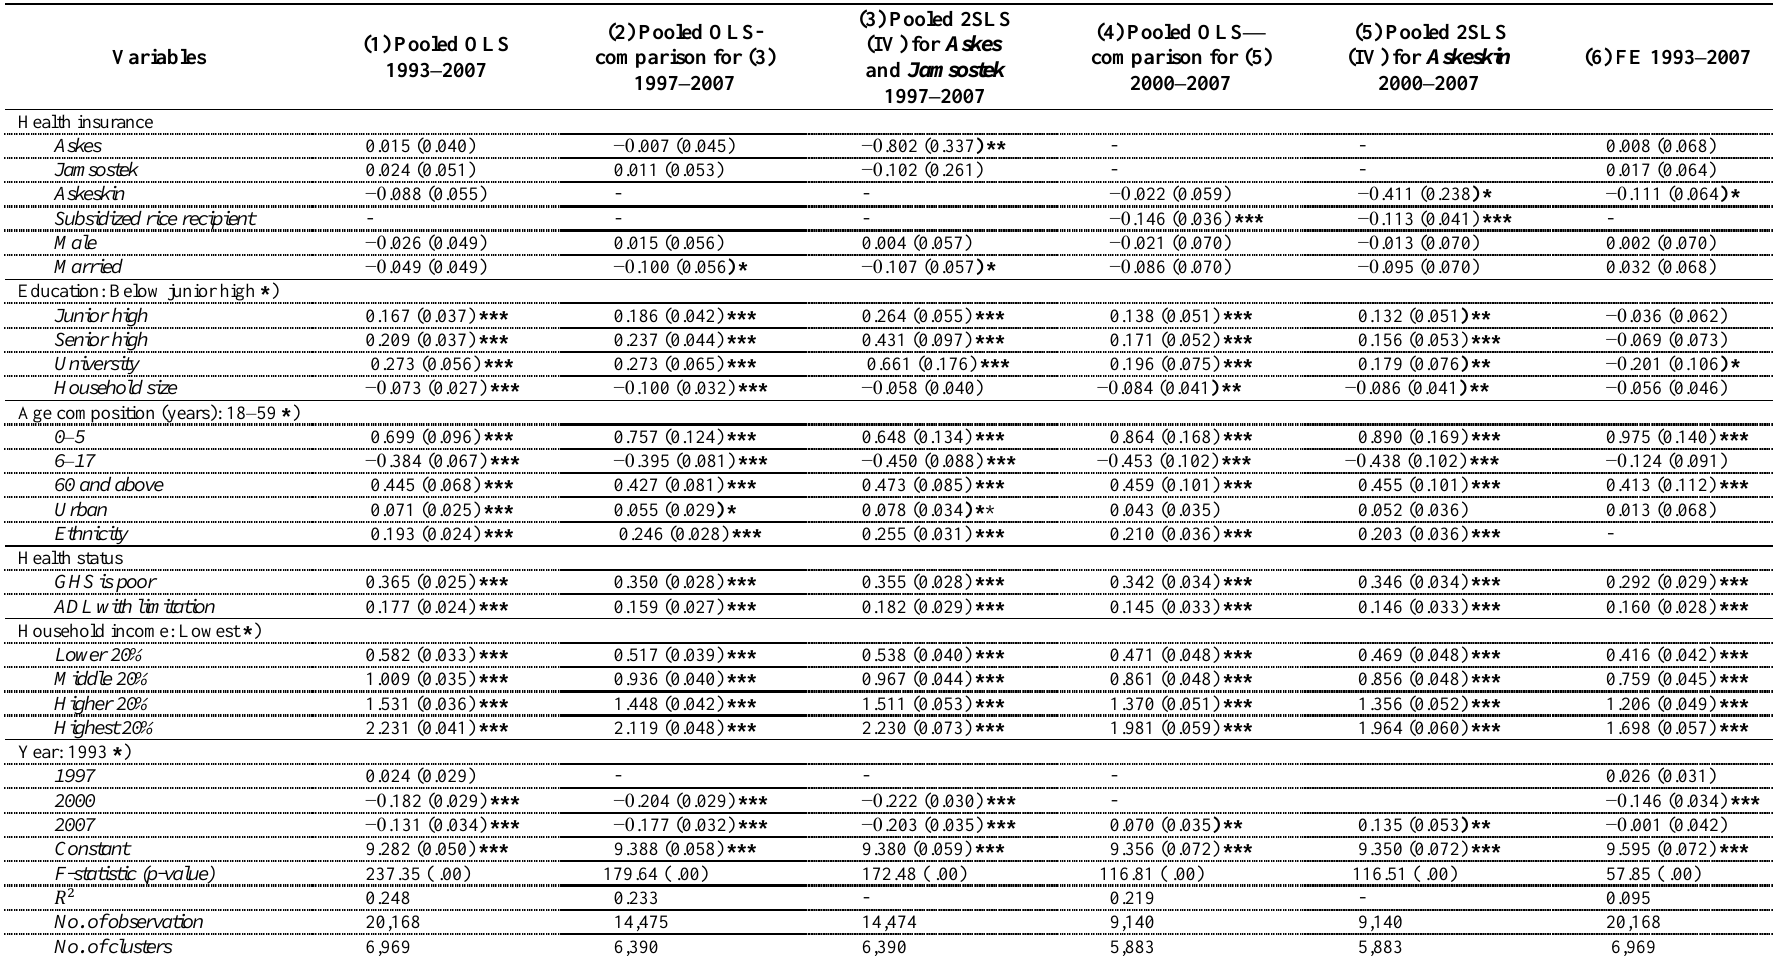
Table 4. The effects of health insurance programs on household out-of-pocket